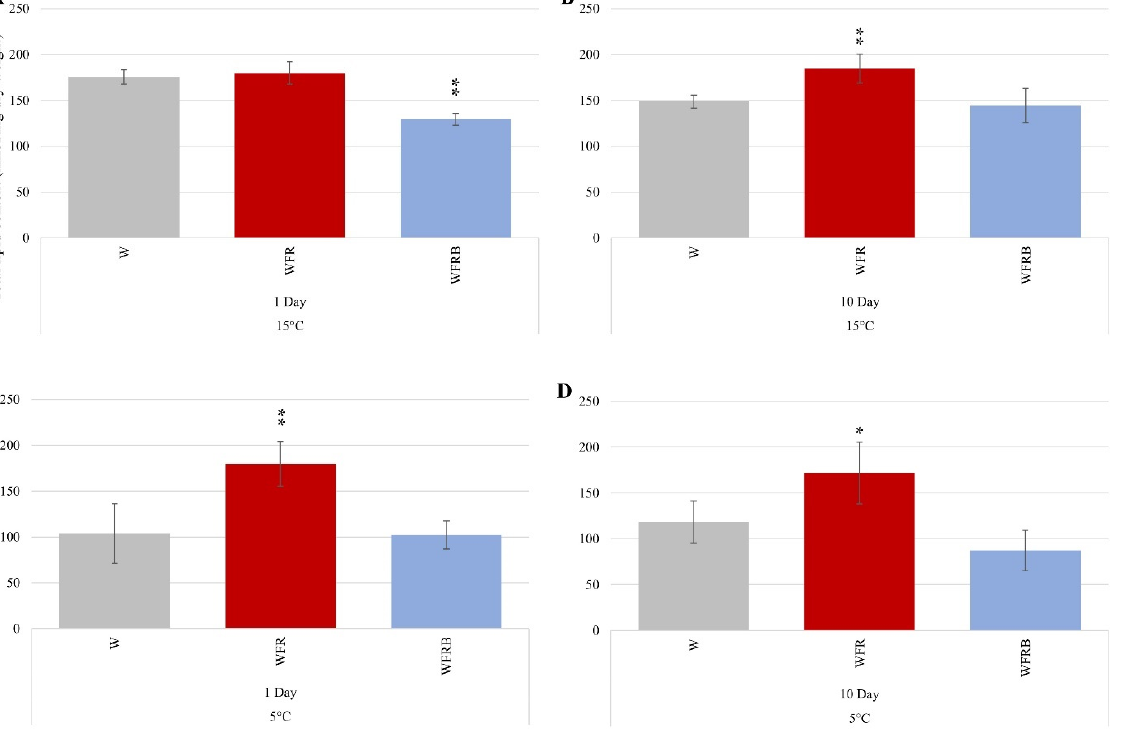
Figure 4. Changes in total lipid content after supplementary FR and Blue light illumination under cold treatments. The signal was expressed as detected signal/mg dry weight (Y axis). The samples were illuminated with white light, white light supplemented with far-red light (WFR) and combined far-red with additional blue light (WFRB). In addition to light treatment, two different temperatures were used (5 and 15 ◦ C). The samples were taken on the first and last days of the treatments, which was ten days in the case of 15 ◦ C and seven in the case of 5 ◦ C. ( A ) 1st day at 15 ◦ C; ( B ) 10th day at 15 ◦ C; ( C ) 1st day at 5 ◦ C; ( D ) 7th day at 5 ◦ C. In all cases, the leaf samples were cut from the central part of the third leaf. Statistical analysis was performed with multiple-way ANOVA and Dunnett’s post-hoc test using white light (W) samples as controls. Measurements were made on 3 to 5 independent biological replicates. Significance levels are indicated by * p < 0.1 and ** p < 0.05.